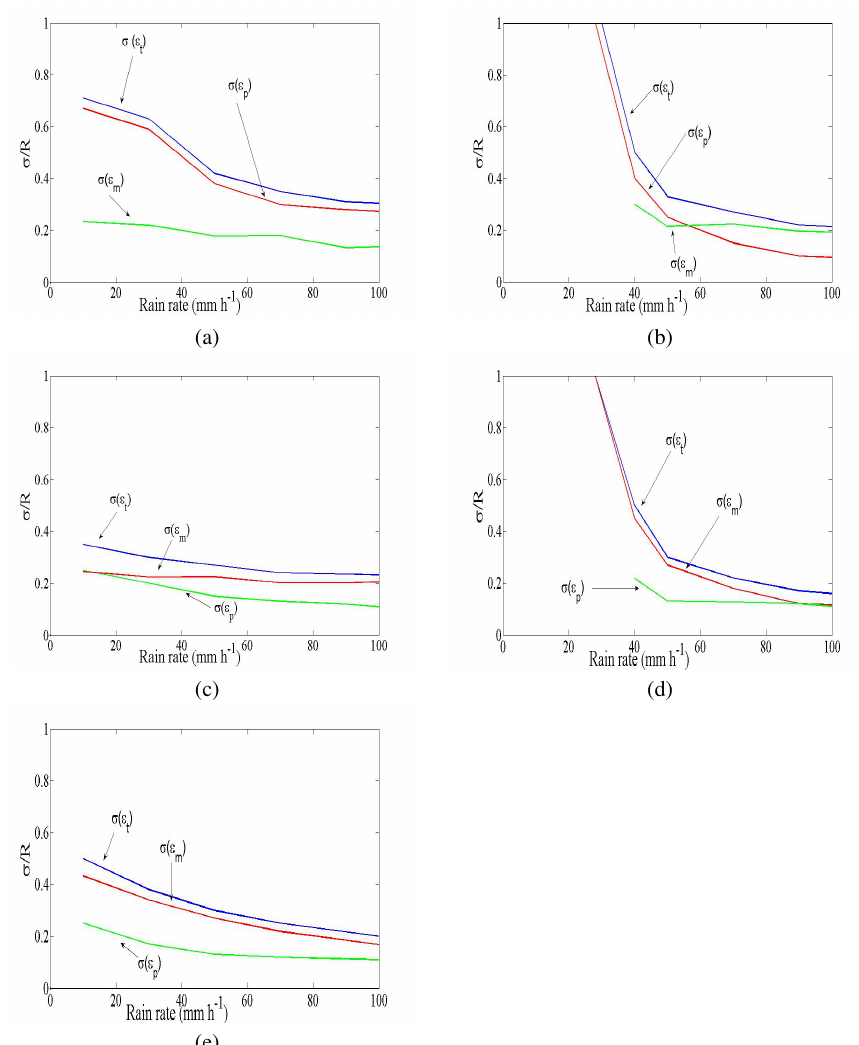
Figure 8. Standard deviations, considered from (Bringi and Chandrasekar (2001))(a) R ( Z ), (b) R ( K dp ), (c) R ( Z , Z dr ), (d) R ( K dp , Z dr ), and for the proposed algorithm (e) R ( Z , K dp , Z dr ).